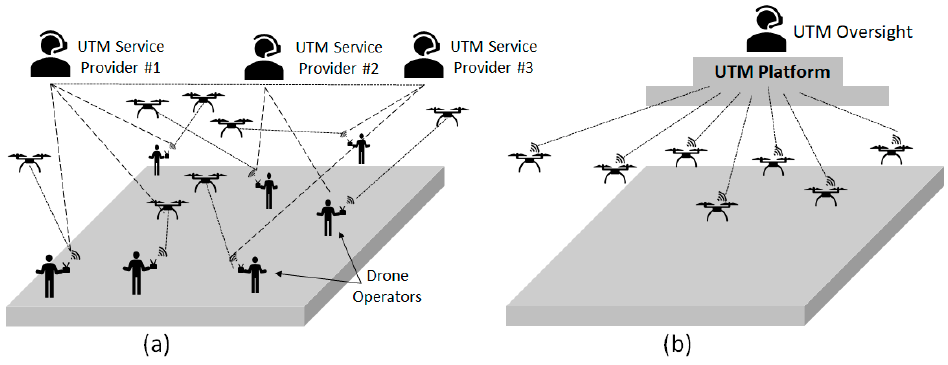
Figure 10. ( a ) Multi-operator, multi-UTM service provider scenario; ( b ) automated urban UTM scenario with drone traffic, coordinated by a UTM platform which is overseen by an UTM director.